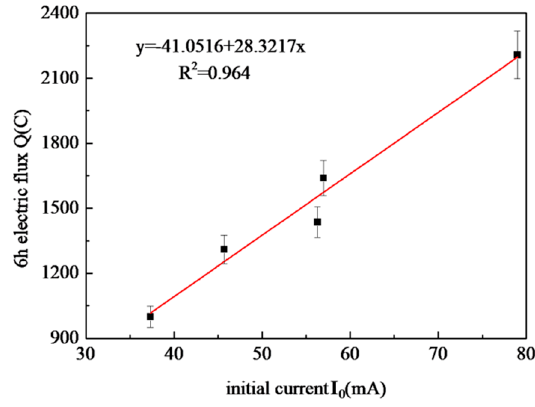
Figure 5. Correlation between initial current and 6 h electric flux.